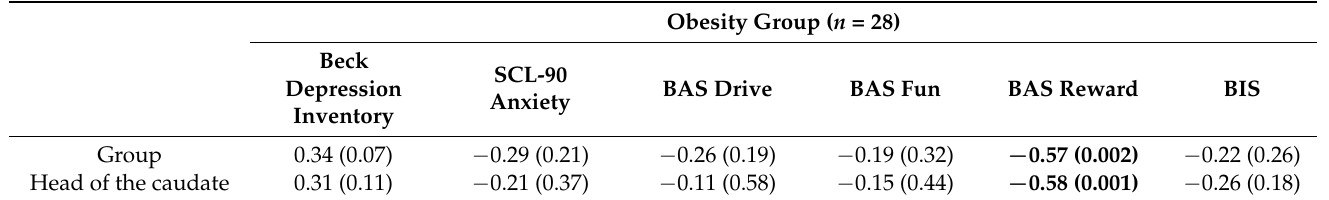
BP ND of dedicated brain areas in participants with